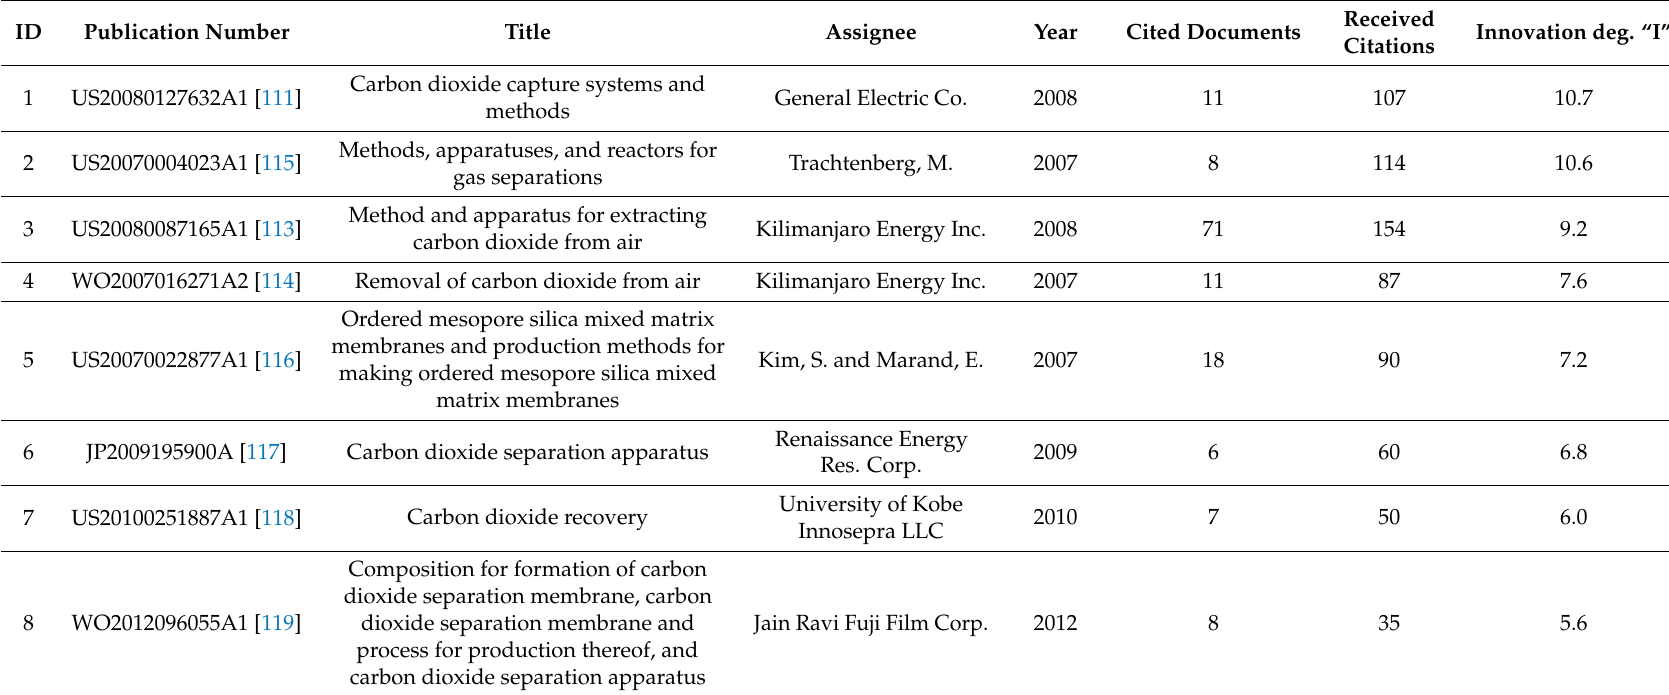
Table 4. Main innovations according to the CPC field Y02C 10/10 and innovation